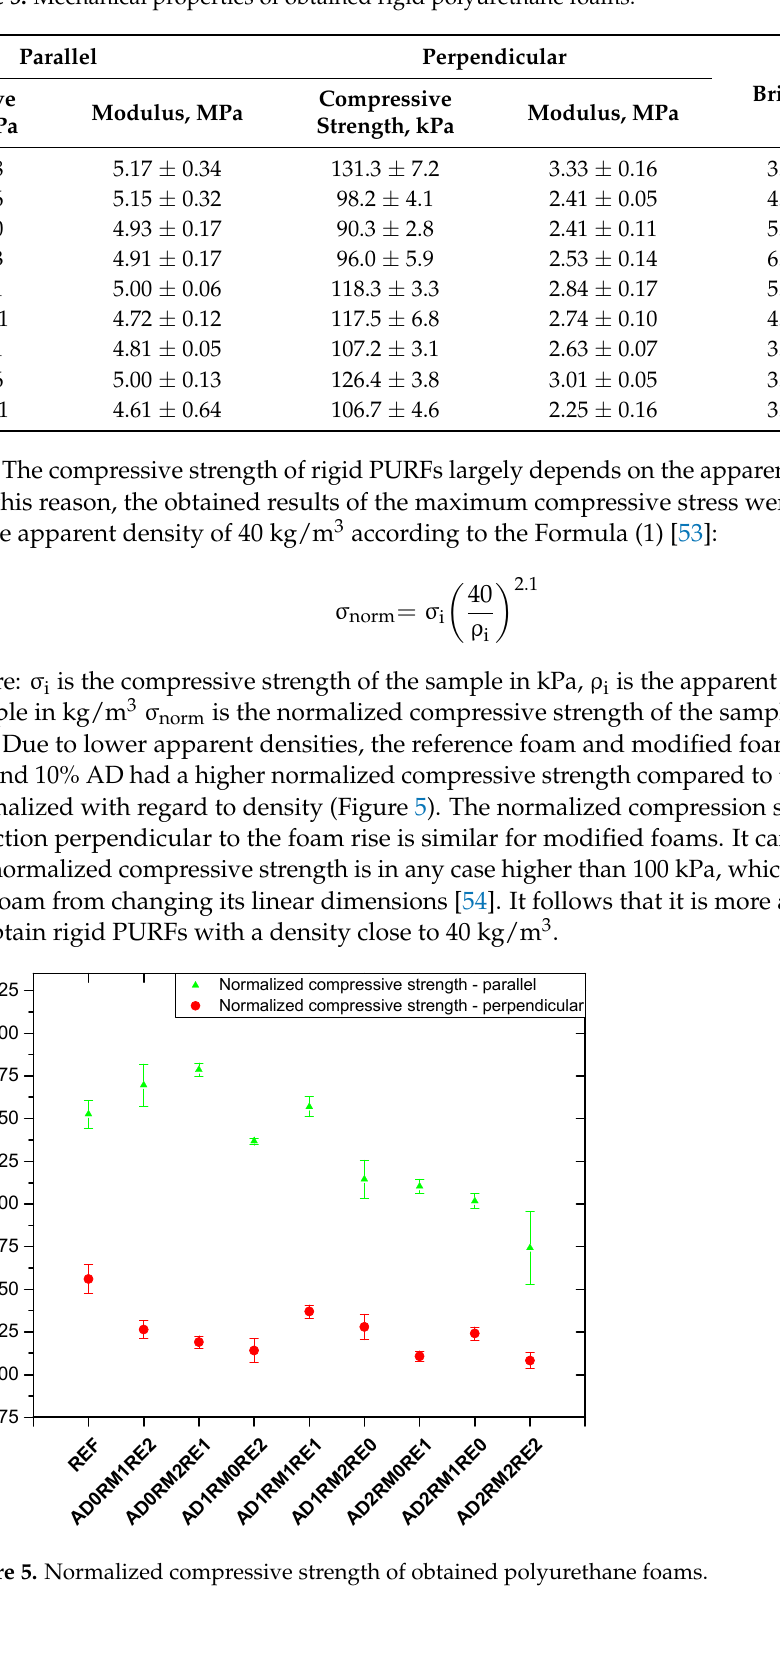
Table 5. Mechanical properties of obtained rigid polyurethane foams.